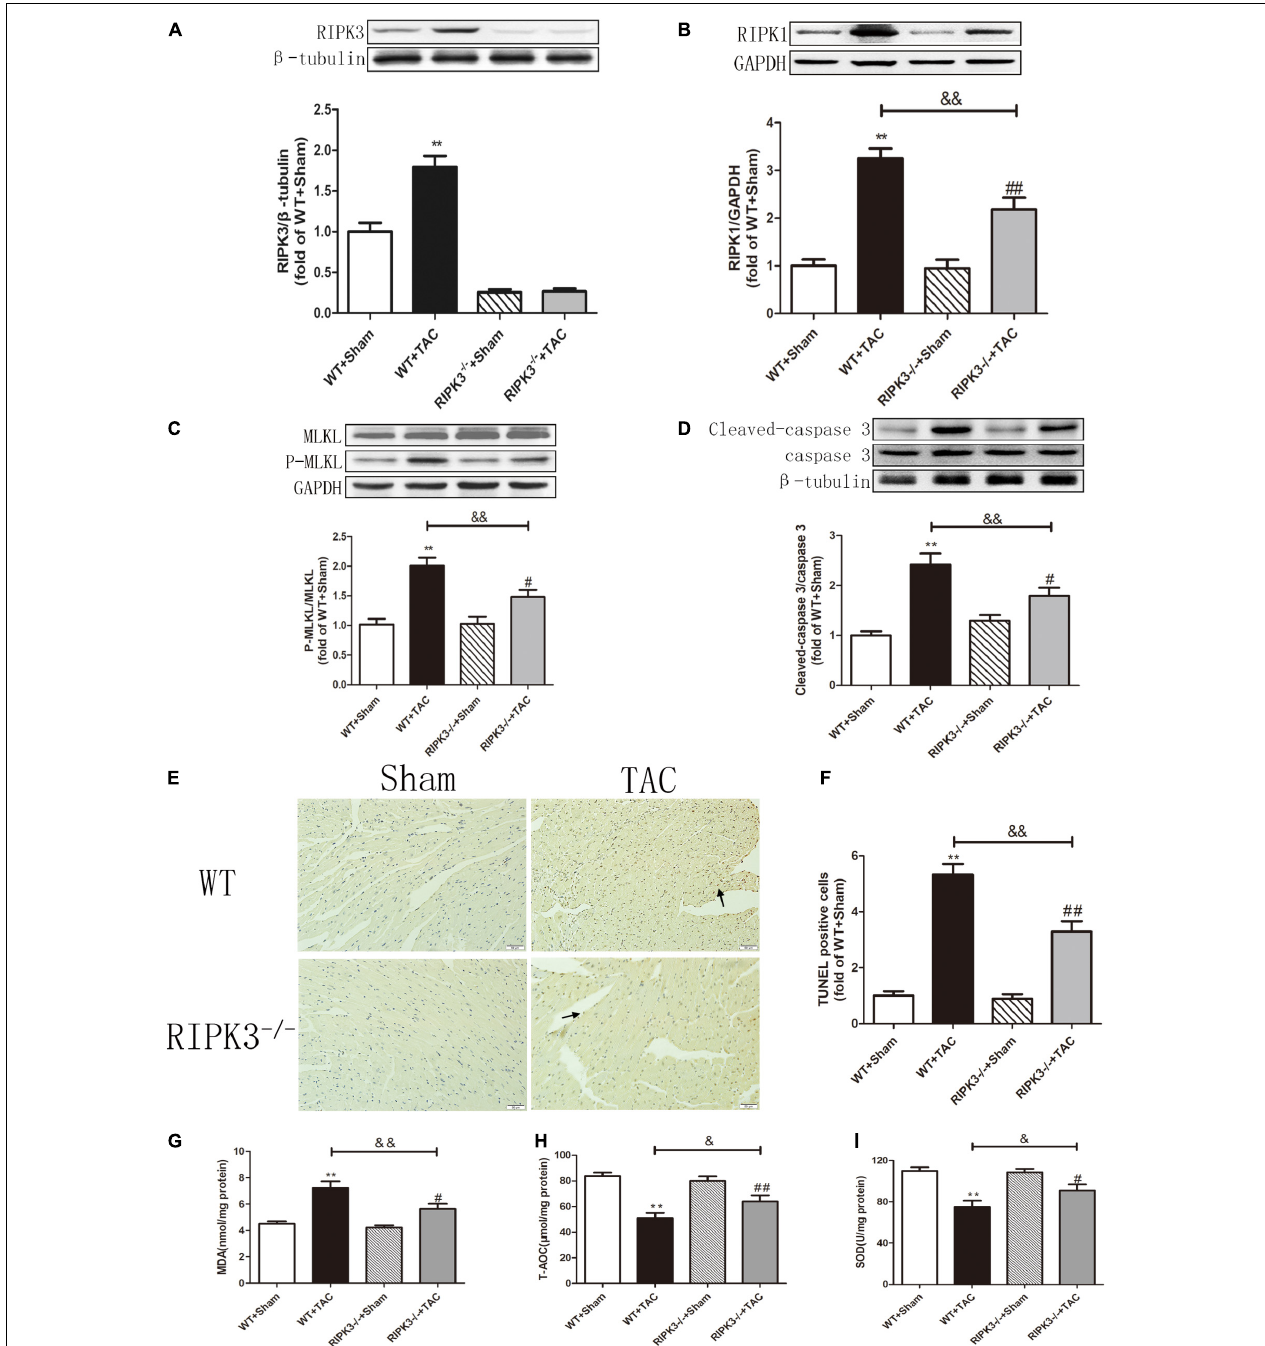
FIGURE 7 | Depletion of RIPK3 can reduce the expressions of RIPK3 and RIPK1, as well as the MLKL phosphorylation level and cardiomyocyte apoptosis in HF mice and improve antioxidant capacity. Male 8-week-old WT and RIPK3 − / − mice were treated with TAC using a 28-g needle. The control group received sham surgery. All groups of mice were given continuous feeding for 6 weeks. Hearts were then obtained for correlative testing. (A) The expression of RIPK3 at the protein level in myocardial tissue was detected by Western blotting analysis, and β -tubulin was used as a loading control. (B) Western blotting analysis was used to detect the expression of RIPK1 at the protein level in myocardial tissue, and GAPDH was used as a loading control. (C) Western blotting analysis was used to detect the expressions of MLKL and P-MLKL at the protein level in myocardial tissue, and GAPDH was used as a loading control. (D) The expressions of cleaved caspase 3 and caspase 3 at the protein level in myocardial tissue were detected by Western blotting analysis, and β -tubulin was used as a loading control. (E) TUNEL staining was used to determine the level of apoptosis in myocardial tissue, bar = 50 µ m. (F) The statistical chart of TUNEL-positive cells. (G) The levels of serum MDA, (H) T-AOC, and (I) SOD. Compared with WT + sham group, ** P < 0.01; compared with RIPK3 − / − + sham group, ## P < 0.01 and # P < 0.05; compared with WT + TAC group, && P < 0.01 and & P < 0.05. n = 6.